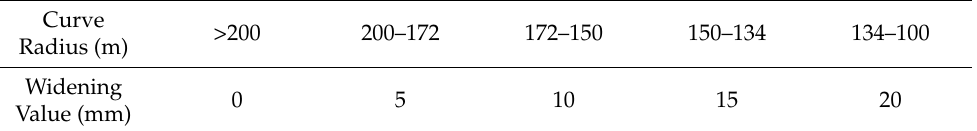
Table 6. Gage widening values in West German railways (mm).